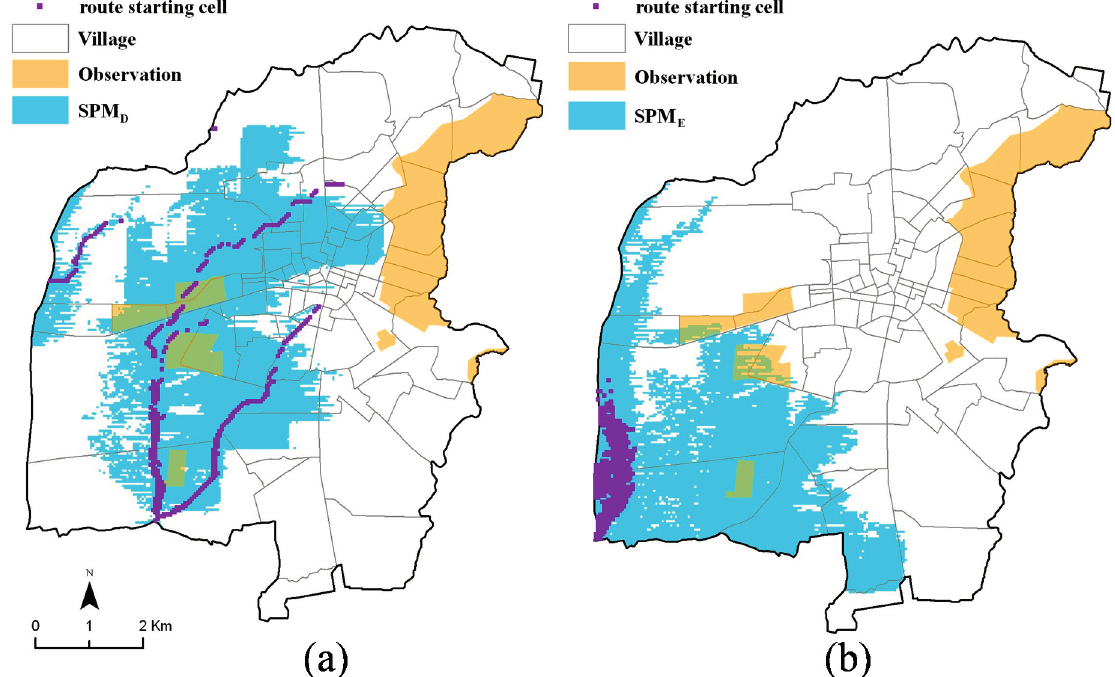
Figure 7. Overlapping flood areas at the grid level between the observed floods and SPM D ( a ) and SPM E ( b ) in